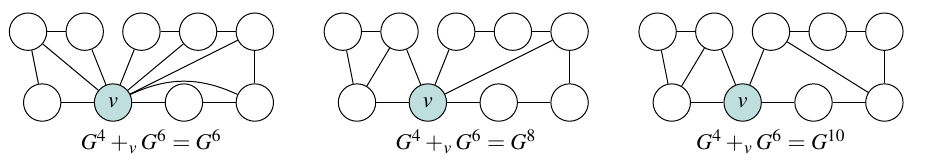
Figure 5. Gluing G 4 and G 6 via vertex v . Figure 6. Gluing G 4 and G 6 via vertex v